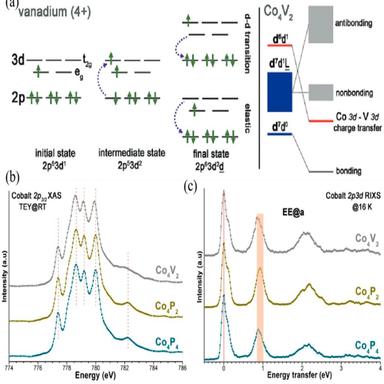
(a) Left panel: a simplified single-electron schematic representation of 2p3d RIXS processes for V4+. Right panel: the energy diagram of lowest bases for the vanadium initial state of Co4V2. (b) and (c) Experimental cobalt 2p3/2 TEY XAS (left panel) and 2p3d RIXS (right panel) spectra of Co4P4 (bottom, green), Co4P2 (middle, dark yellow) and Co4V2 (top, gray) . (For interpretation of the references to colour in this figure legend, the reader is referred to the Web version of this article.)